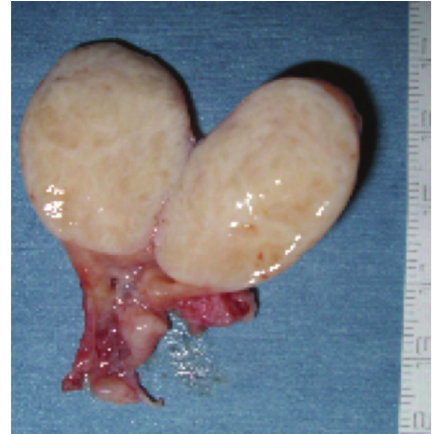
Figure 3: Macroscopic features of the excised